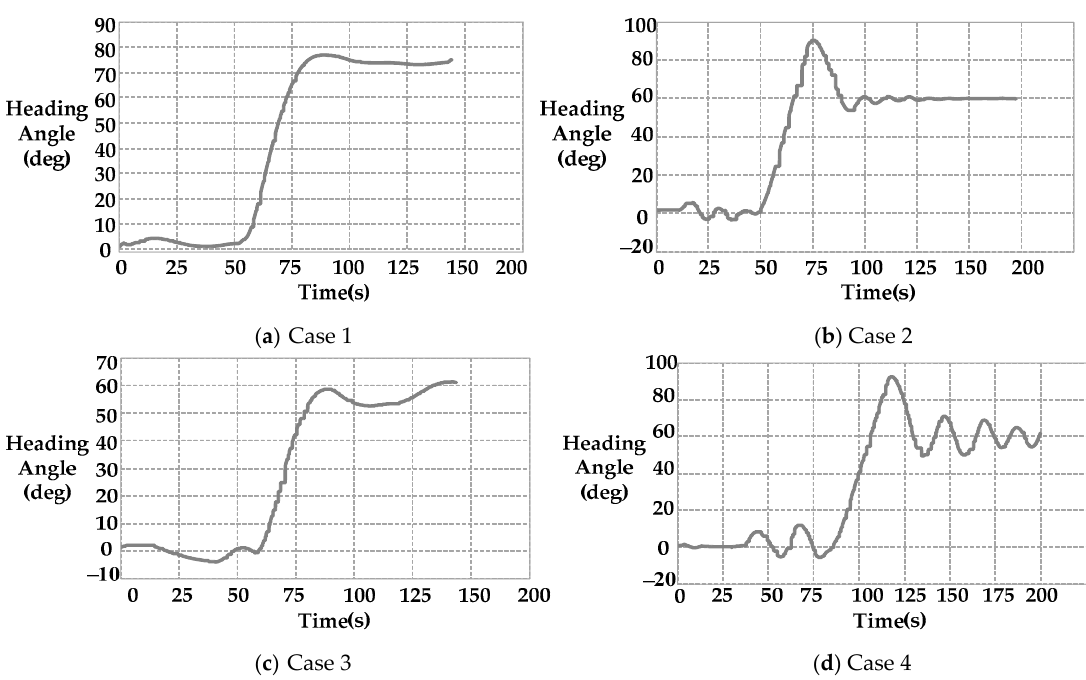
Figure 17 . Ship heading angle in the tank experiment of ship automatic berthing.